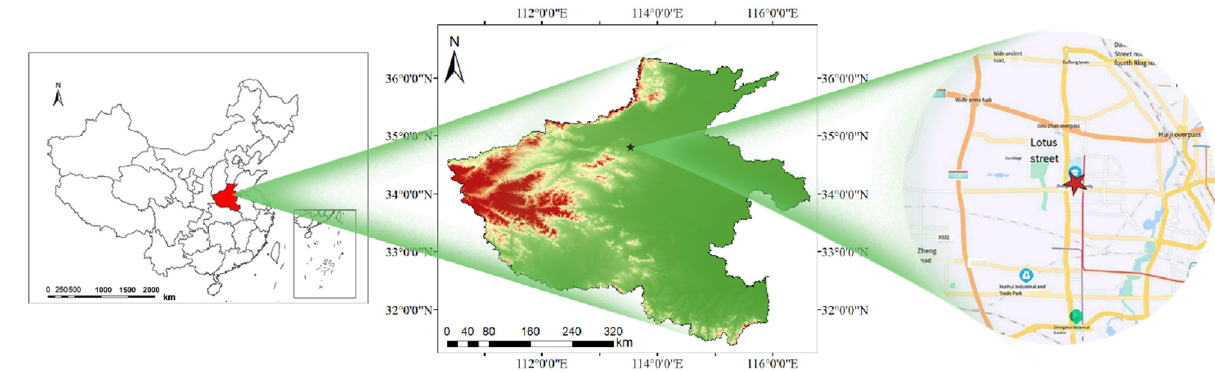
Figure 1. Location of the sampling point in this study.